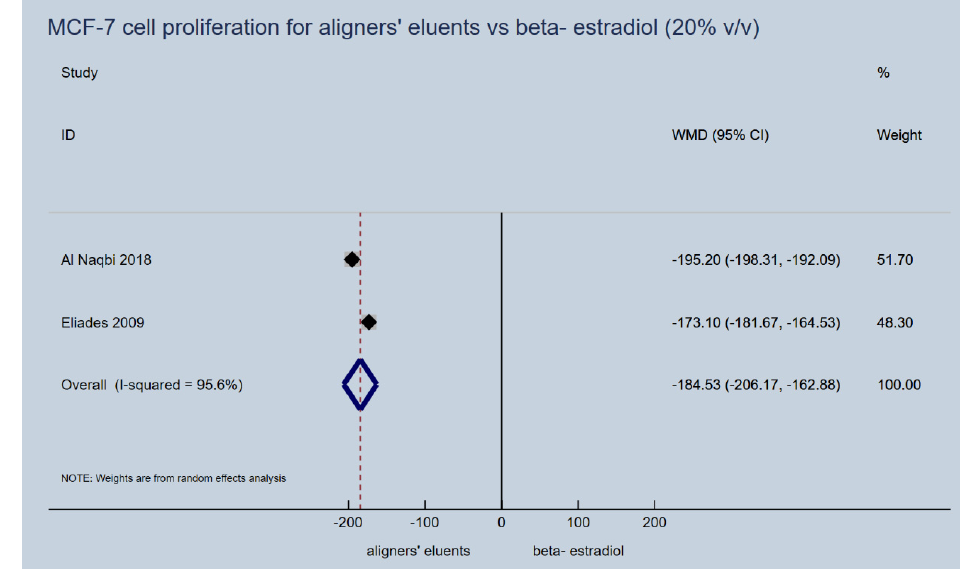
Figure 4. Random effects meta-analysis on the effect of thermoplastic appliances’ eluents versus beta- estradiol (20% v/v) to induce proliferation activity of MCF-7